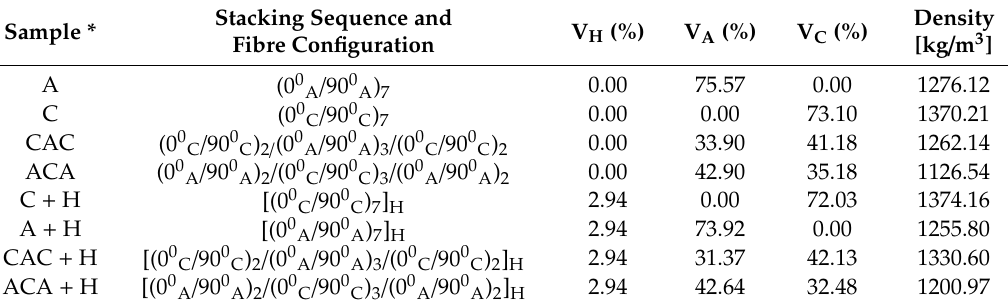
Table 2. Sequences of fabric arrangement and fibre volume fractions of the laminates.